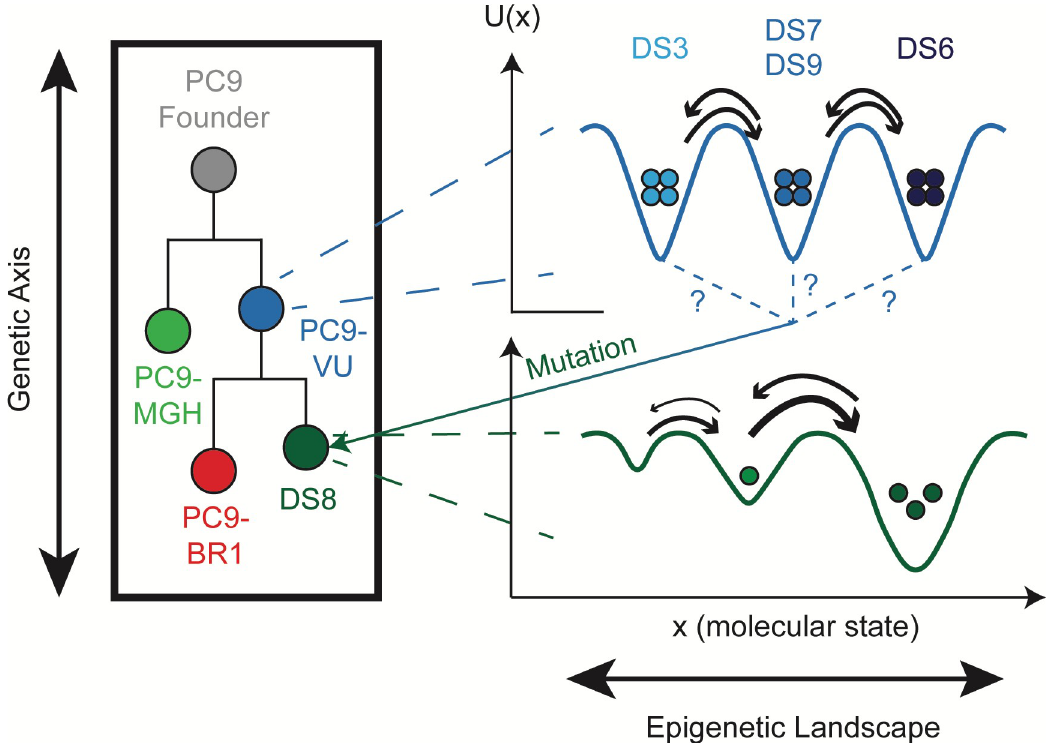
Fig 6. Schematic interpretation of the results of our analyses on the PC9 cell line family. Cell line versions PC9-MGH (light green) and PC9-VU (blue) represent different genetic clones within our in vitro tumor model that emerged from a common PC9 founder clone (gray). Each genetic clone has an associated epigenetic landscape, including PC9-VU, which has at least 3 distinct basins corresponding to the sublines DS3, DS7/DS9, and DS6. Cell line version PC9-BR1 (red) was derived from PC9-VU via drug- induced genetic clonal selection in EGFRi, while DS8 (dark green) independently acquired a genetic resistance mutation in the absence of selective drug pressure. However, it remains unclear from which basin DS8 arose (signified by question marks) and whether the resistance mutation was acquired before or after the subline was established (see S1 Text and S11 Fig). Note that PC9-VU is depicted as lying closer in the phylogenetic tree to the PC9 founder line than PC9-MGH because PC9-VU appears to be a closer genetic descendent of the founder, based on our genomic data. Likewise, DS8, which is believed to have emerged only recently, is depicted closer than PC9-BR1 to the common ancestor PC9-VU. EGFRi, EGFR inhibitor.